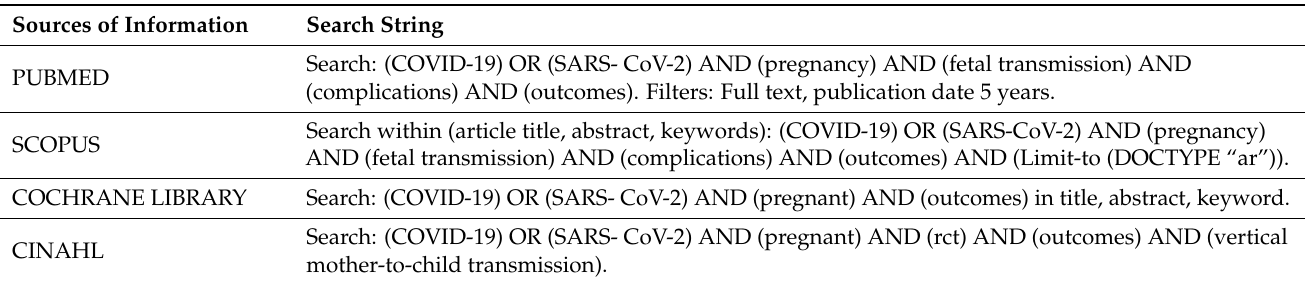
Table 1. Search strategies.